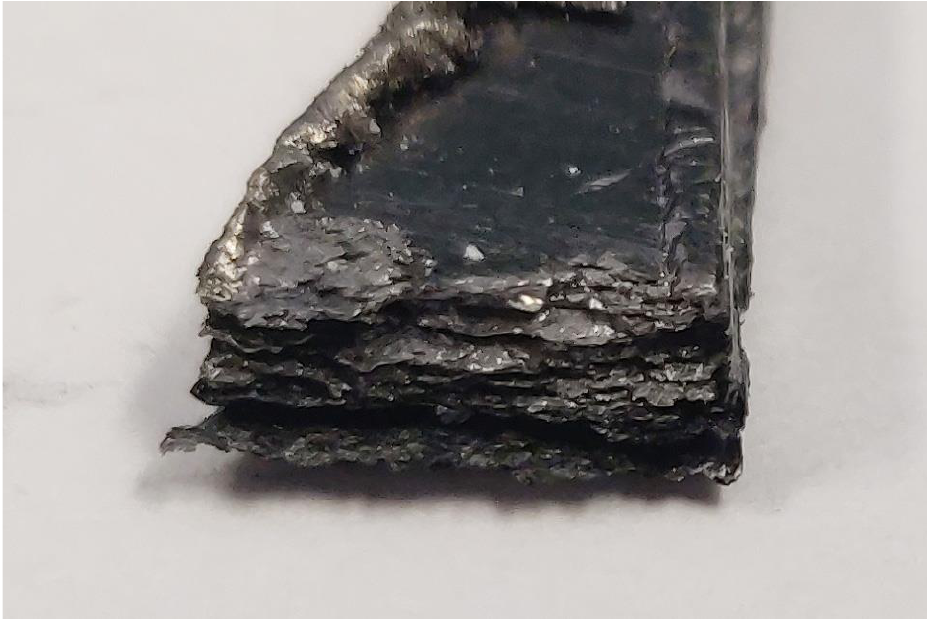
Figure 12. Image of the SGL Carbon TF 6 sample with the layered structure clearly visible.